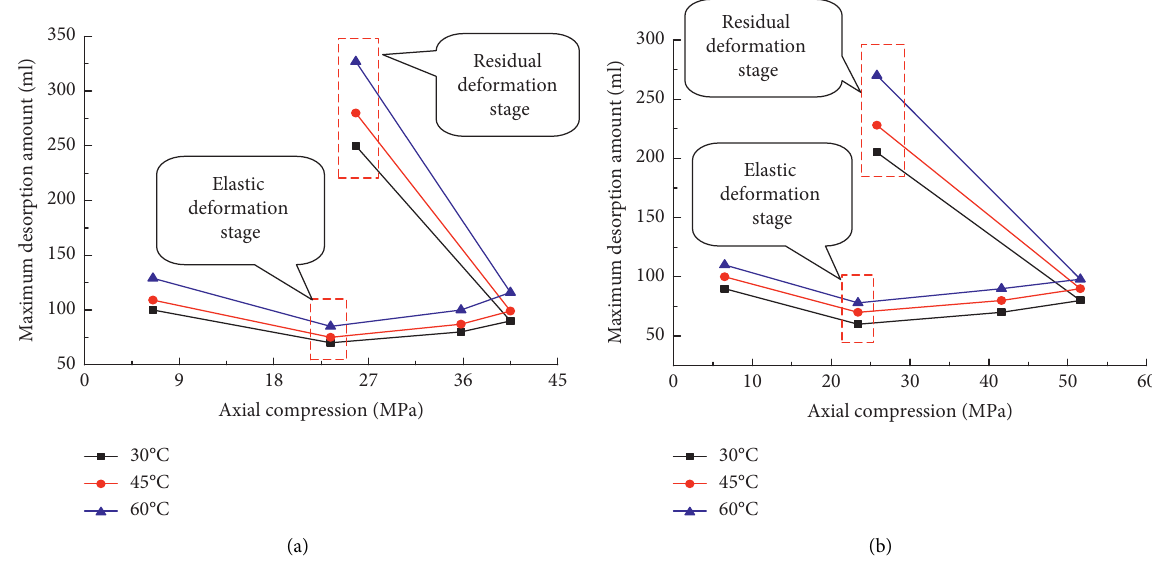
Figure 12: Relation curve between maximum desorption amount and axial pressure under the confining pressure of (a) 3MPa and (b)